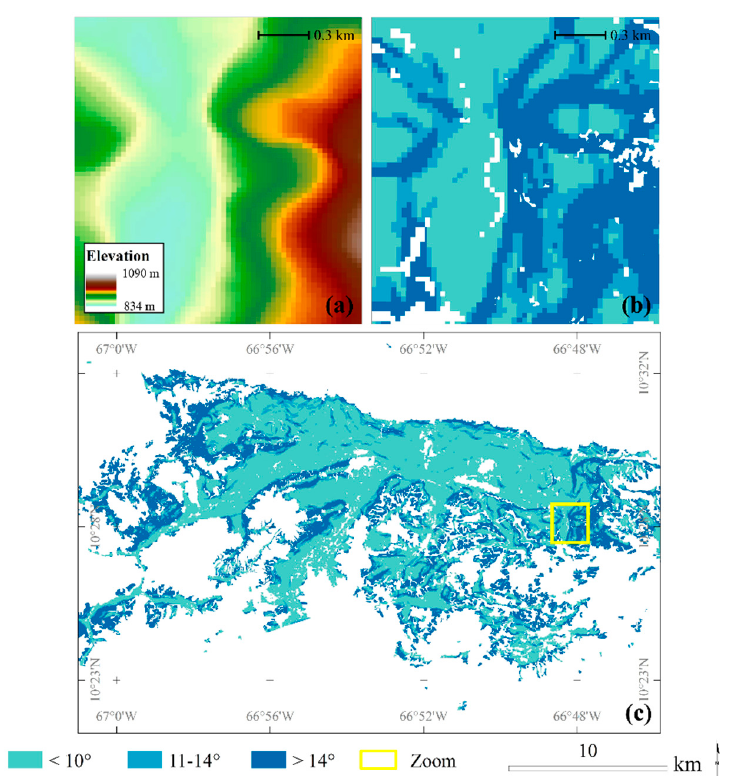
Figure 5. ( a ) Classification of the topographic situation in Caracas based on the ASTER Digital Elevation Model resulting in ( b , c ) three classes ( < 10 ◦ , 10–14 ◦ , > 14 ◦ ) of slope inclination (only built-up area is displayed).